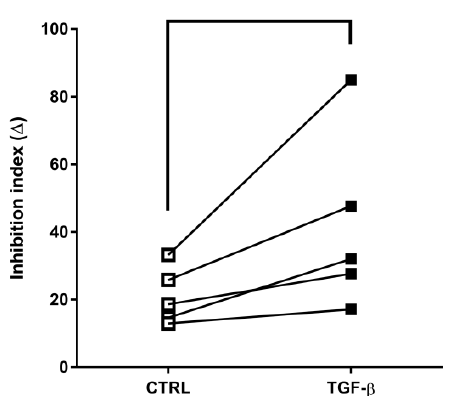
Figure 8. TGF- β -induced epithelial-mesenchymal transition (EMT) enhances ABCC1 activity. A549 cells (1 × 10 5 cells/mL) were incubated with 5 ng/mL TGF- β for EMT induction. After 48 h, ABCC1- mediated efflux assays were performed as described in Material and Methods. ABCC1 activity is represented by inhibition index ( ∆ ). Squares and lines represent each paired experiment. Values of significance were represented by (*) for p < 0.05 from five independent experiments. phenotype. Since TGF- β increases th e expression of ABCB1 and ABCC1, mainly increas- ing ABCC1 activity, we evaluated whether cells treated with TGF- β would be resistant to the induction of cell death by daunorubicin. This drug is an anthracycline with antibiotic and antitumor properties, which induces DNA damage mediated by quinone-generated redox activity, intercalation distortion of the DNA double helix or stabilization of the cleavable complex formed between DNA and topoisomerase II [47]. Additionally, dauno- rubicin is transported by ABCB1 [13] and by ABCC1 [48]. According to the literature, treatment with daunorubicin increases the percentage of PI + cells, that is, non-viable cells, from 8.04 ± 0.73 to 70.67 ± 3.52 (Figure 9). As expected, the cytokine TGF- β showed no toxic effect on A549 cells. Unlike what was expected, cells pretreated with TGF- β did not show resistance to daunorubicin. After 48 h of incubation with TGF- β for EMT induction and increase of ABC transporters, the addition of daunorubicin increased the percentage of PI + cells to 94.70 ± 1.43 in 24 h, suggestive of the collateral sensitivity phenomenon.